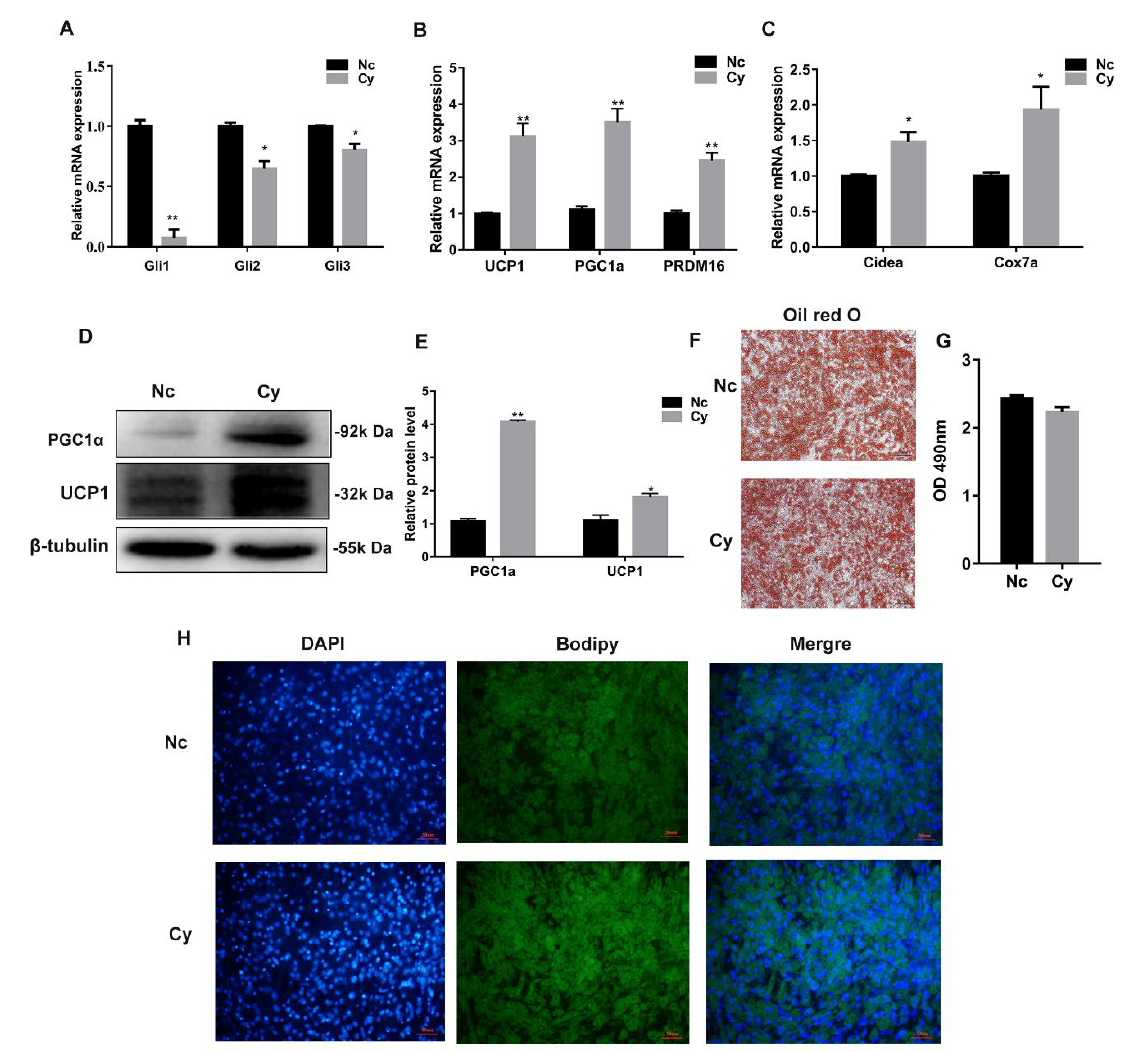
Figure 3. Hh signaling pathway inhibition promoted white adipocyte browning. ( A ) RT-qPCR analysis of key transcription factor gene expression of the Hh signaling pathway. ( B ) RT-qPCR was used to detect white adipose thermogenesis relative gene expression. ( C ) RT-qPCR analysis of mitochondrial marker gene expression. ( D ) Western blotting analysis of protein change of genes associated with white adipose thermogenesis relative genes. ( E ) The quantified results of the protein level. ( F ) Oil red O staining. ( G ) The result of oil red O extraction. ( H ) Bodipy staining. Data were representative of means ± SD of three independent experiments. Scale bar = 10 µm, * p < 0.05; ** p < 0.01. (Note: Nc is the cyclopamine (Cy) control, Cy was dissolved in ethanol).